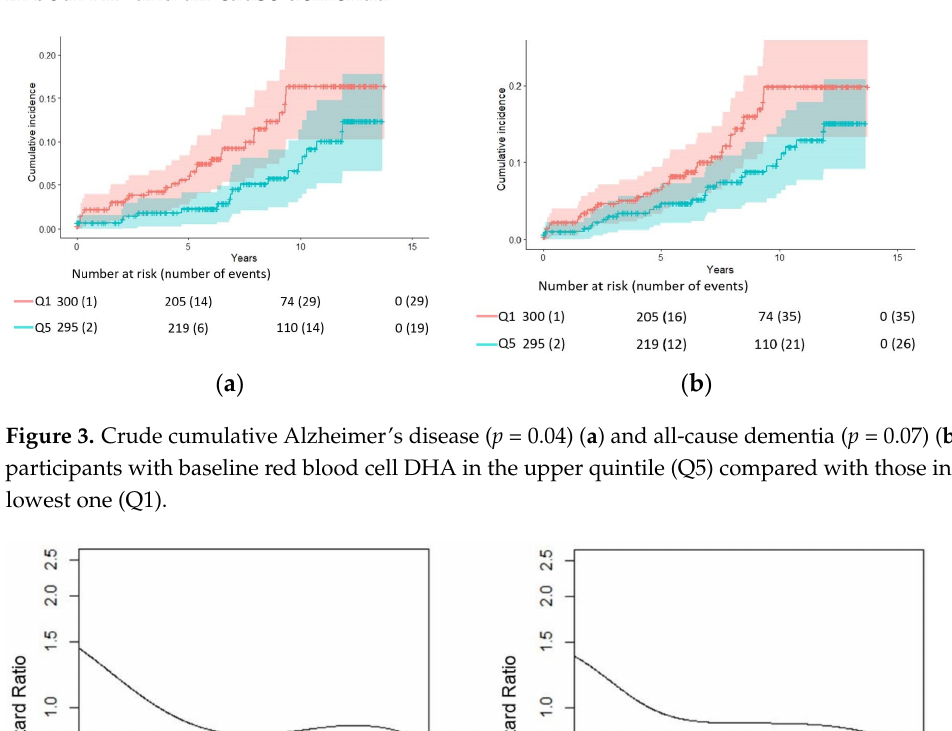
Table 2 for detailed information on statistical models.